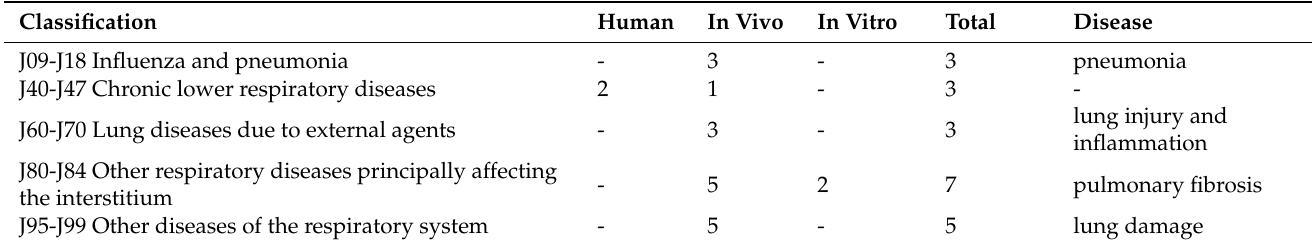
Table 13. The statistics of pharmacological results and its major diseases of SMC by experimental type in X Diseases of the respiratory system of ICD-10.